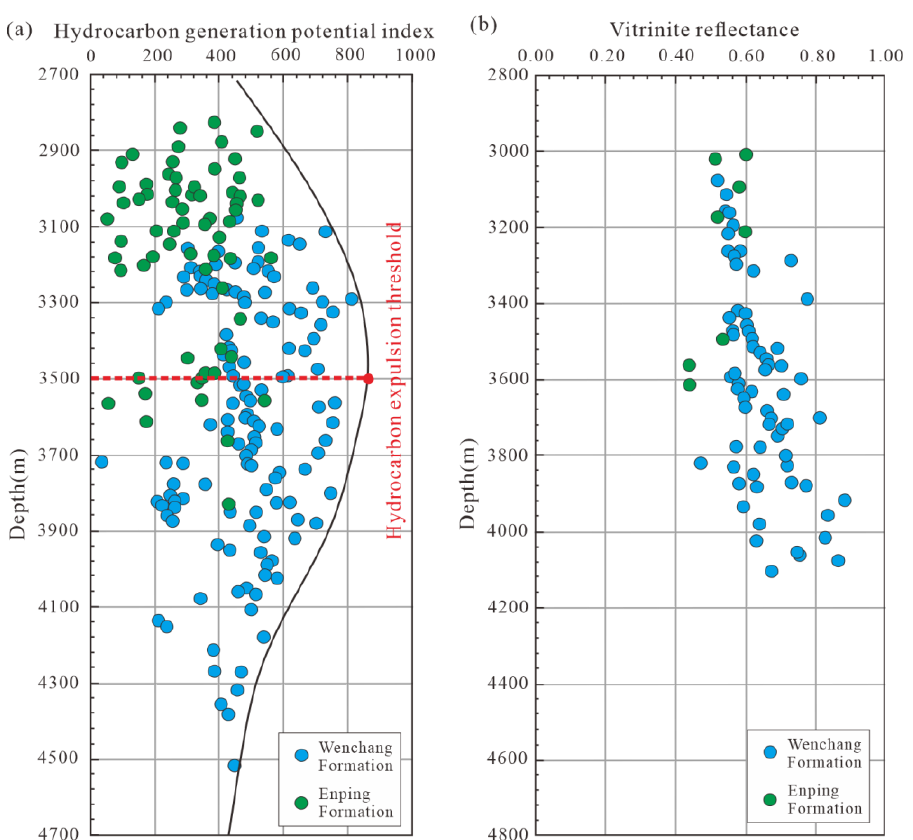
Figure 3. ( a ) Determination of HET map with depth variation of HGP index in southern Lufeng sag; ( b ) variation of vitrinite reflectance (Ro) with depth of the WC and the EP in the southern Lufeng sag.